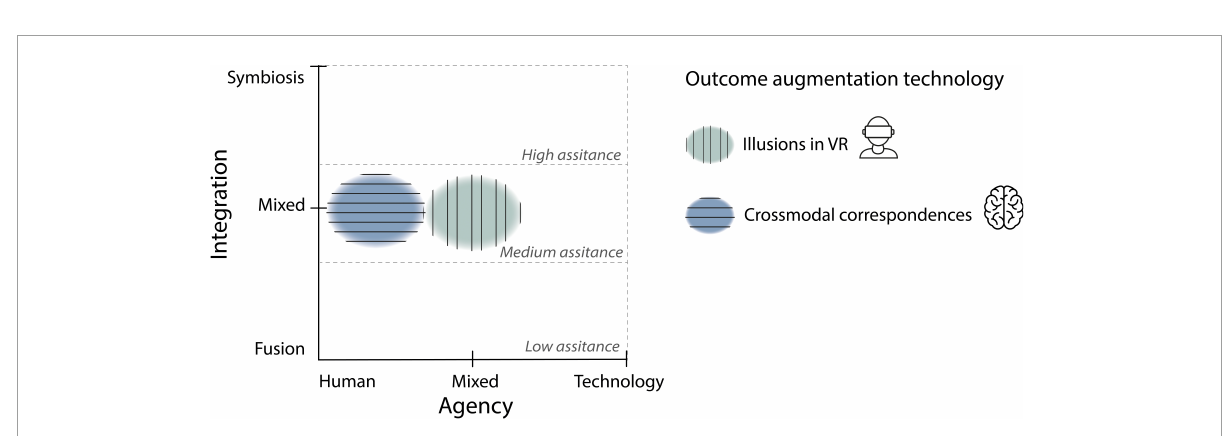
FIGURE13 Map of the two types of outcome augmentation technology that we identified (Illusions in VR and crossmodal correspondences) and their relationship with assistance level, agency, and